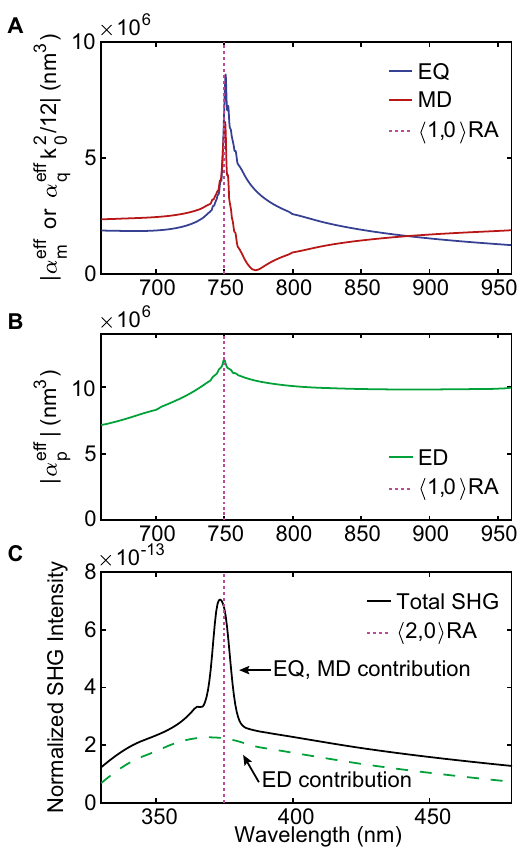
Figure 3: (Color online) Effective polarizabilities of (A) EQ, MD and (B) ED in the periodic nanoparticle array with lattice periods p x =510nmand p y =250nm.MultipolesareshowninpanelsAandB separately forclarity. (C) Relative strengthof the SHG in the periodic array. The SHG with x -polarized incident electric fi eld exhibits a narrow resonance peak around the wavelength 375 nm corresponding to the excitation of EQ- and MD-multipole resonance around the wavelength 750 nm. The vertical dotted line denotes the wavelengthofthe 〈 1 , 0 〉 and 〈 2 , 0 〉 Rayleighanomaly.Thedashedline inpanelCdenotestheEDcontributionatfundamentalwavelengthto the SHG.